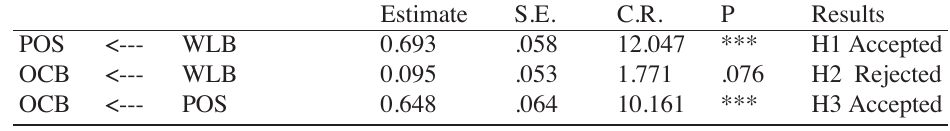
Results of Path Analysis – SEM.